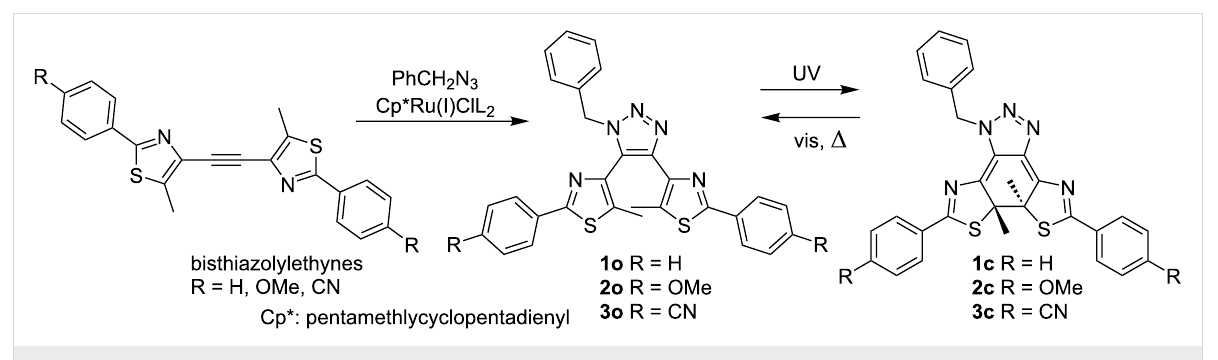
Scheme 2: Synthesis and photochromism of